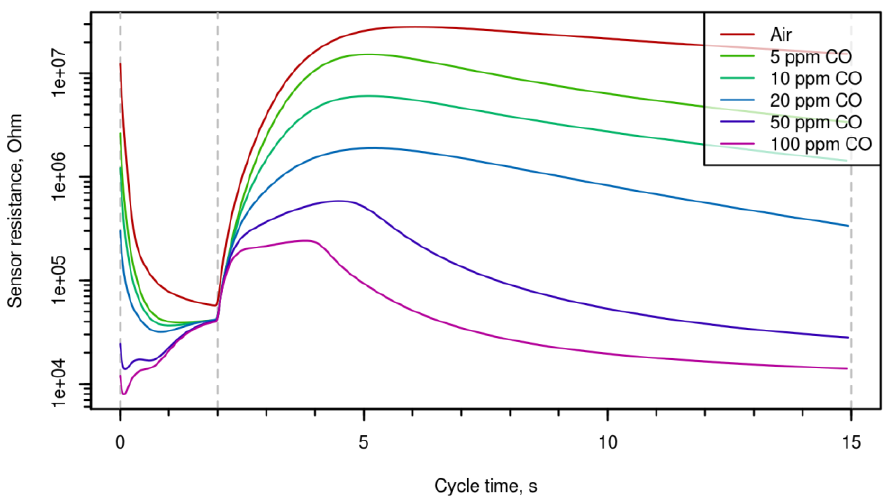
Figure 2. Time-resistance dependence for different carbon monoxide concentrations during one measurement